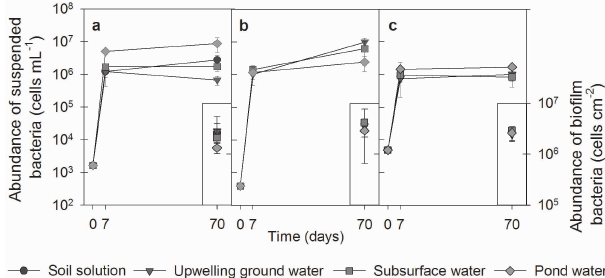
Fig. 5. Bacterial abundance in four types of water collected in the Chicken Creek Catchment and incubated for 70 days following in- oculation with microbial communities from (a) soil, (b) stream sed- iment, and (c) pond water. Line plots represent suspended bacteria and inserted dot plots denote biofilm bacteria on glass slides ex- posed for 70 days. Symbols and error bars indicate means ± 1SD, n =